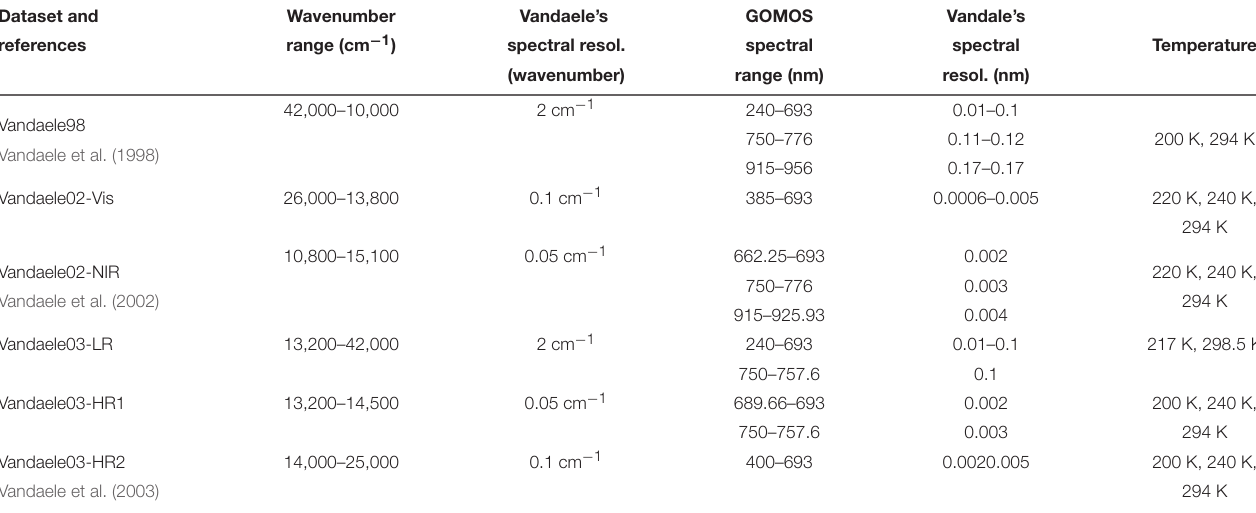
TABLE 4 | Spectral range and resolution in cm − 1 of the different datasets of NO 2 absorption cross-section spectra published by Vandaele et al., and corresponding resolution in nm at the range of the different GOMOS spectrometers.